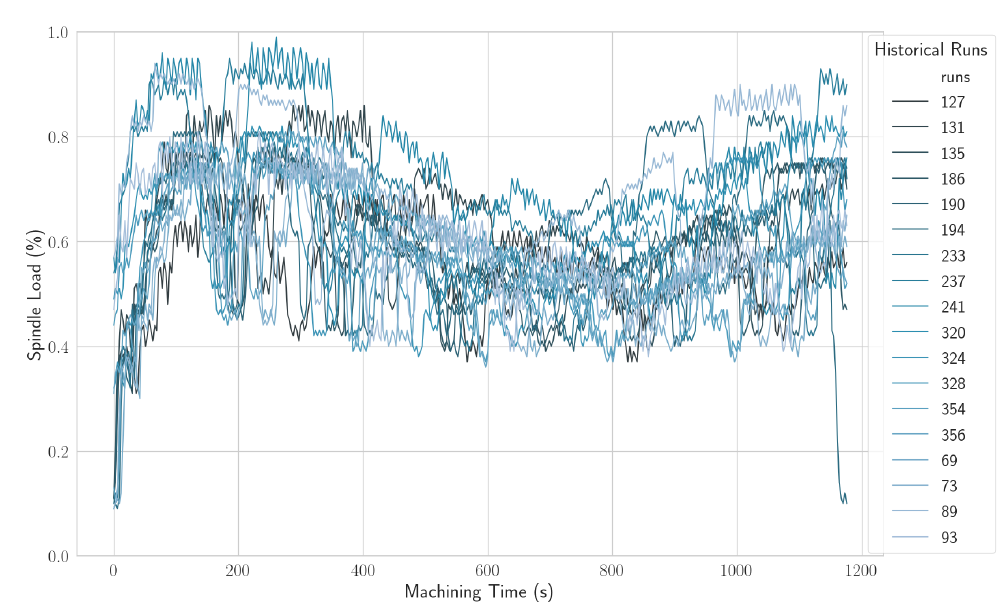
Figure 4. Raw data for the program 1543 and tool 6040 on the T5-1